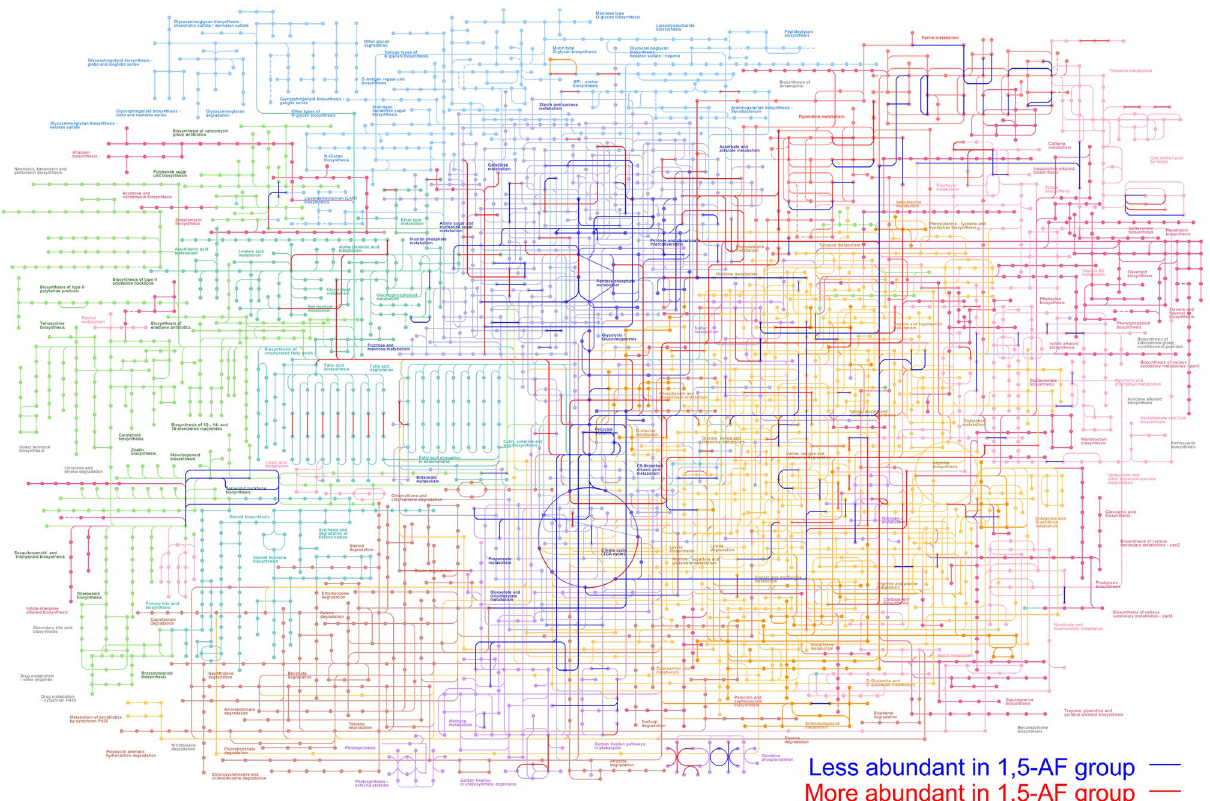
Figure 2. Comprehensive map of the metabolic pathways upregulated or downregulated by dietary supplementation with 1,5-AF. The metagenomic reads of the gut microbiota in mice treated with or without 1,5-AF (n = 8 in each group) were mapped against a functional reference database, and gene abundances were determined as reads per kilobase of exon per million mapped sequence reads (RPKM). The differences in RPKM values between the 1,5-AF-treated mice and the control mice were analysed using White’s non-parametric t -test with FDR adjustment for multiple comparison. Significantly more or less abundant genes in the gut microbiota of the 1,5-AF-treated mice are shown with red or blue lines, respectively. The metabolic map was created using the Kyoto Encyclopedia of Genes and Genomes (KEGG) mapper 28 with the copyright